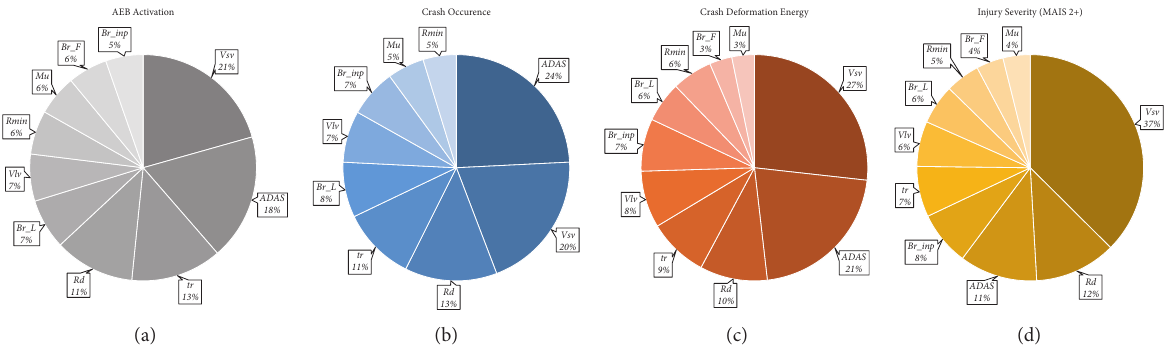
Figure 9: The results of parameter importance evaluation using Boruta model for each outcome. (a) AEB activation. (b) Crash occurrence. (c) Crash deformation energy. (d) Injury severity (MAIS 2+).